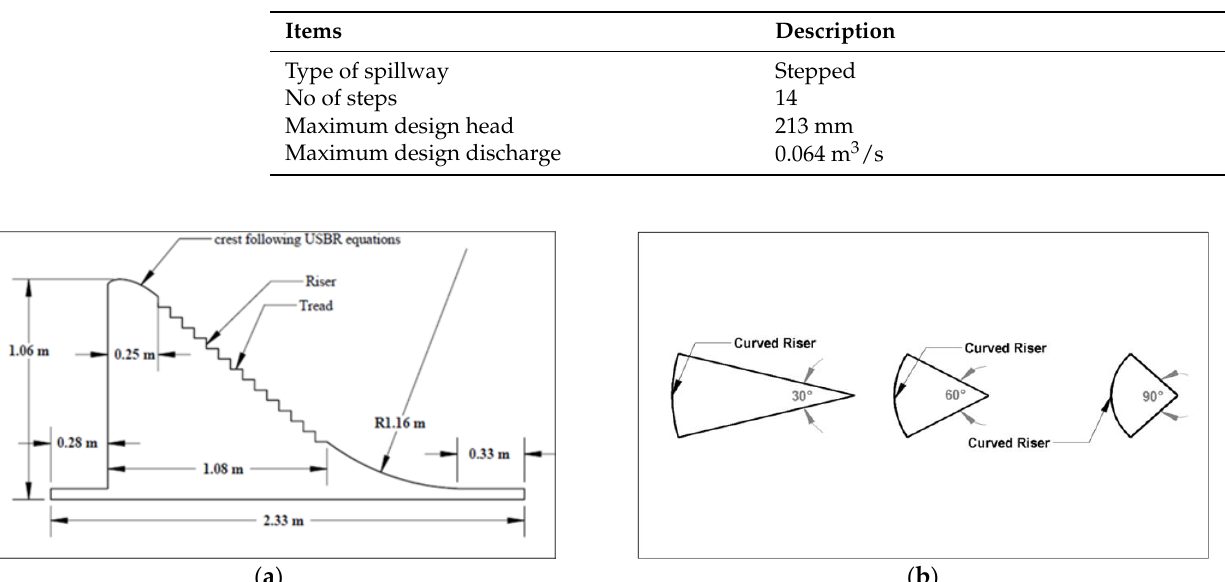
Table 2. General Features of Khanpur Dam. Table 3. General features of Model 2.